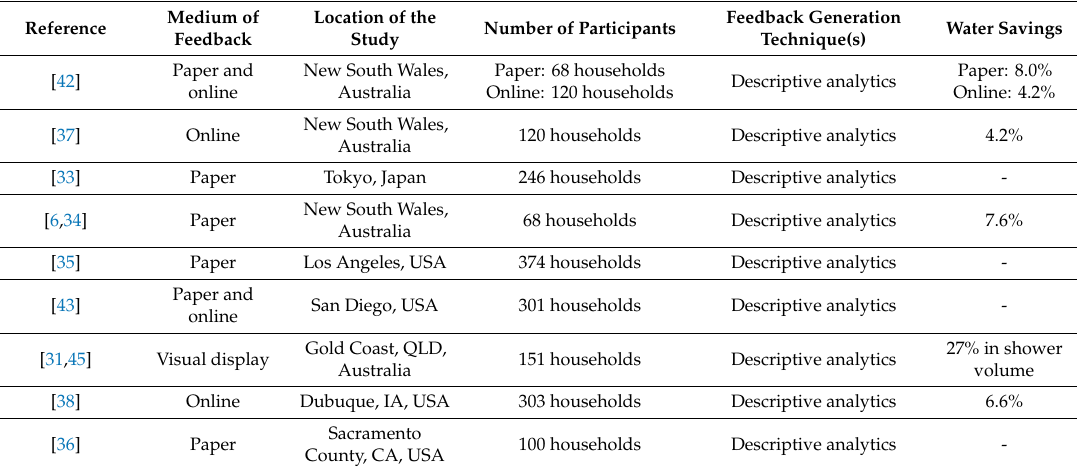
Table 2. Key characteristics of the literature on water-use